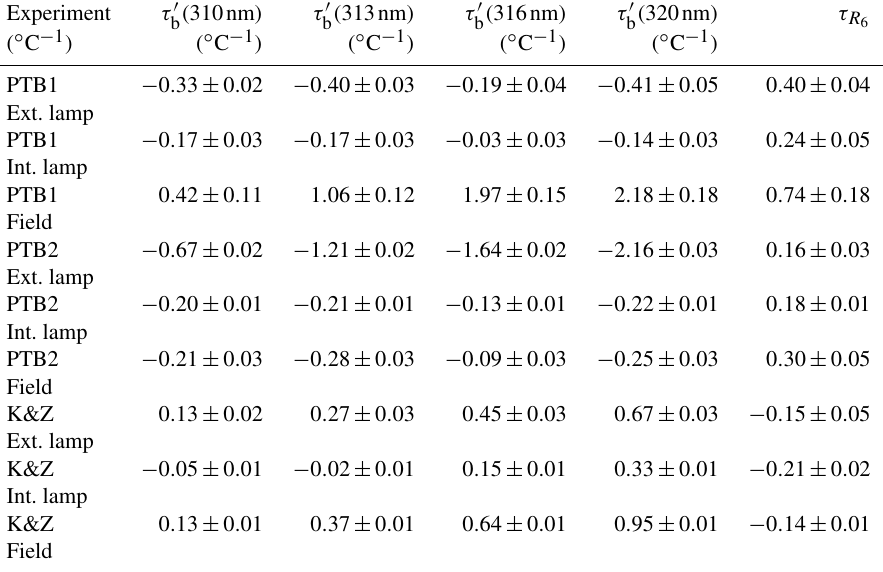
Table 1. Temperature coefficients obtained from the linear regression of the individual measurements, for slits 2, 3, 4 and 5 retrieved from Brewer measurements relative to slit 1 ( τ (cid:48) ) and temperature coefficient for R 6 ( τ R ). Rows are grouped in three blocks representing the tree b 6 experiments (PTB1, PTB2 and K&Z). For each experiment, results from external (top row) and internal (middle row) lamp measurements in the temperature chamber and derived from field data (bottom row) are shown.